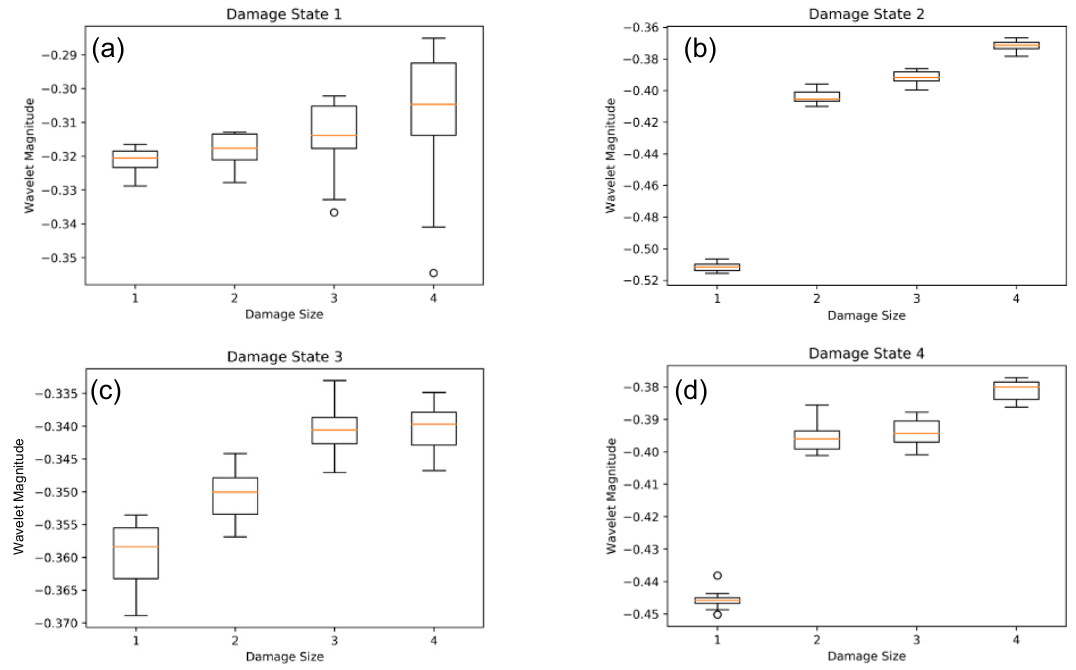
Figure 5. Damage sizes 1, 2, 3, and 4 correspond to damage sizes 500, 600, 800, and 900 μ m, respectively. Each of the subplots in the figure ( a – d ) shows the comparison between the different damage sizes of a particular damage state. The boxplot of all four damage states is shown above, in ascending order of progression.